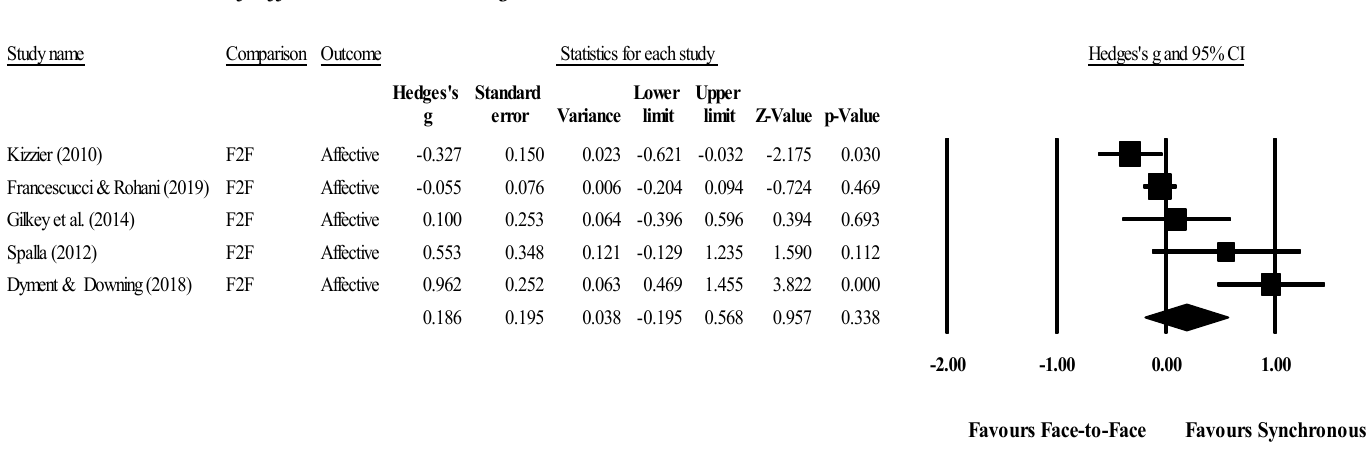
Figure 7 Forest Plot of Affective Outcomes (Synchronous vs.